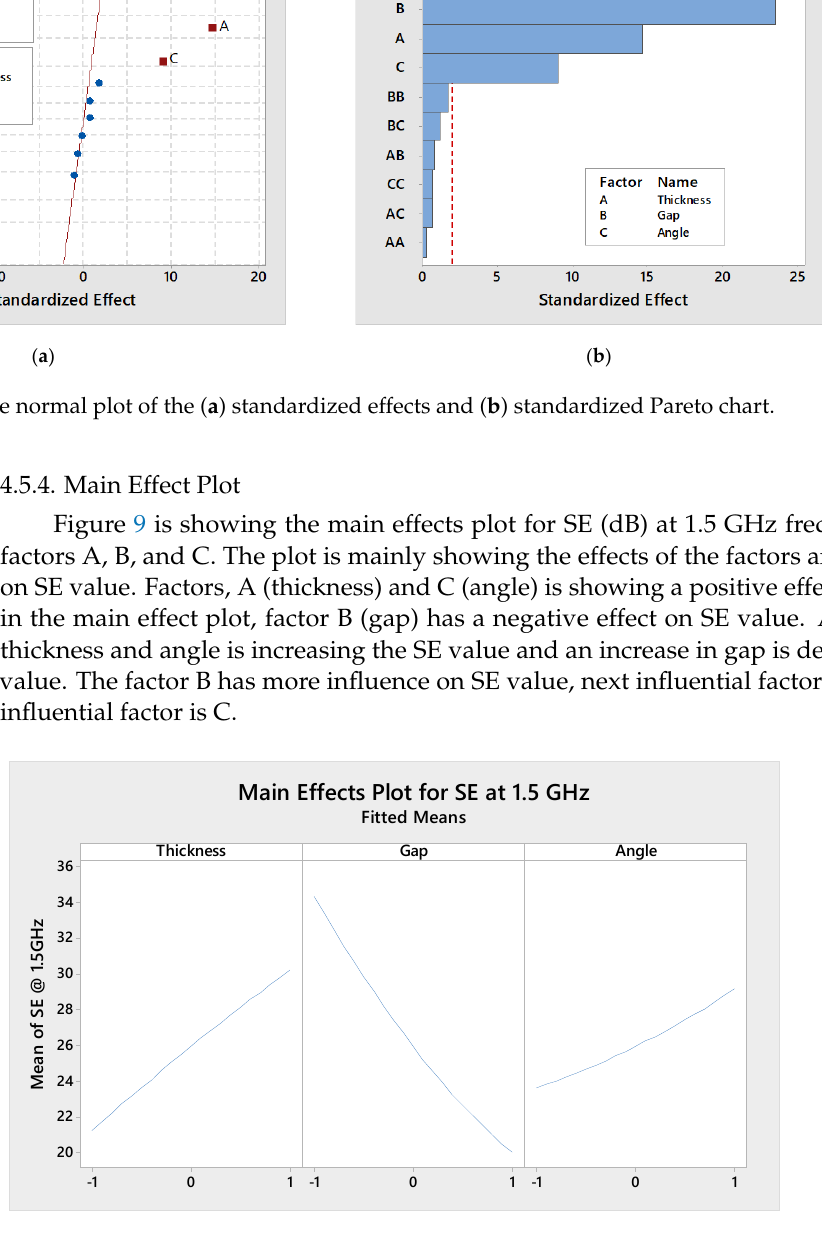
Figure 9. Main effects plot of the factors.